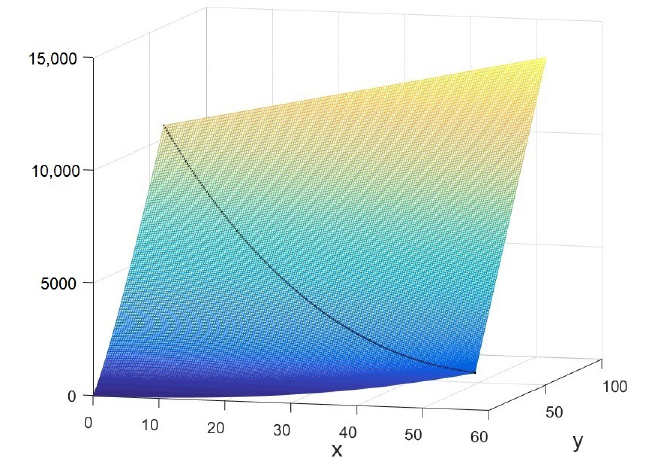
Figure 4. The numerical value function and threshold boundary (solid black curve) for the following set of parameter values: σ 1 = 0.2, σ 2 = 0.6, α 1 = 0.02, α 2 = 0.02, r = 0.1, ρ = 0, Q 1 = 5, Q 2 = 10, I = 2000 and different values of x and y .